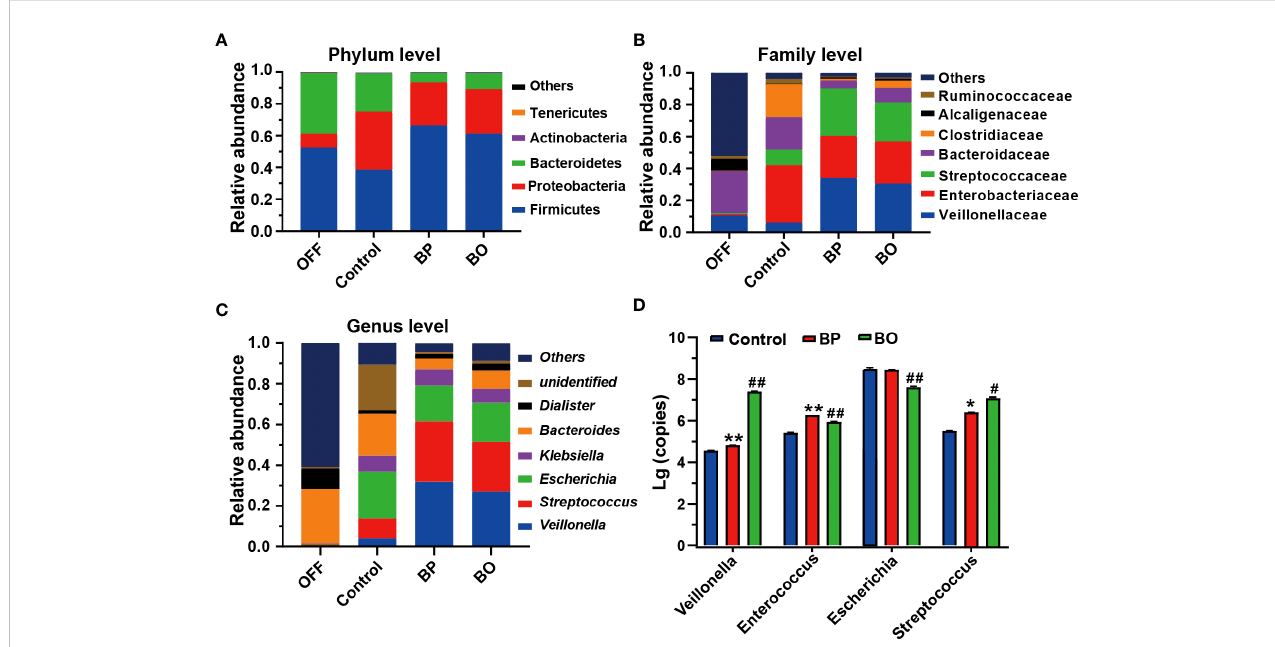
FIGURE 5 Bacterial taxonomic pro fi ling of fermentation broth after different treatments. (A) Gut microbiota composition at the phylum level. (B) Gut microbiota composition at the family level. (C) Gut microbiota composition at the genus level. (D) Changes of bacteria copies at the genus level by qRT-PCR. Data were presented as mean ± SD (n = 3). * p < 0.05, ** p < 0.01, Control group vs. BP group; # p < 0.05, ## p < 0.01, Control group vs. BO